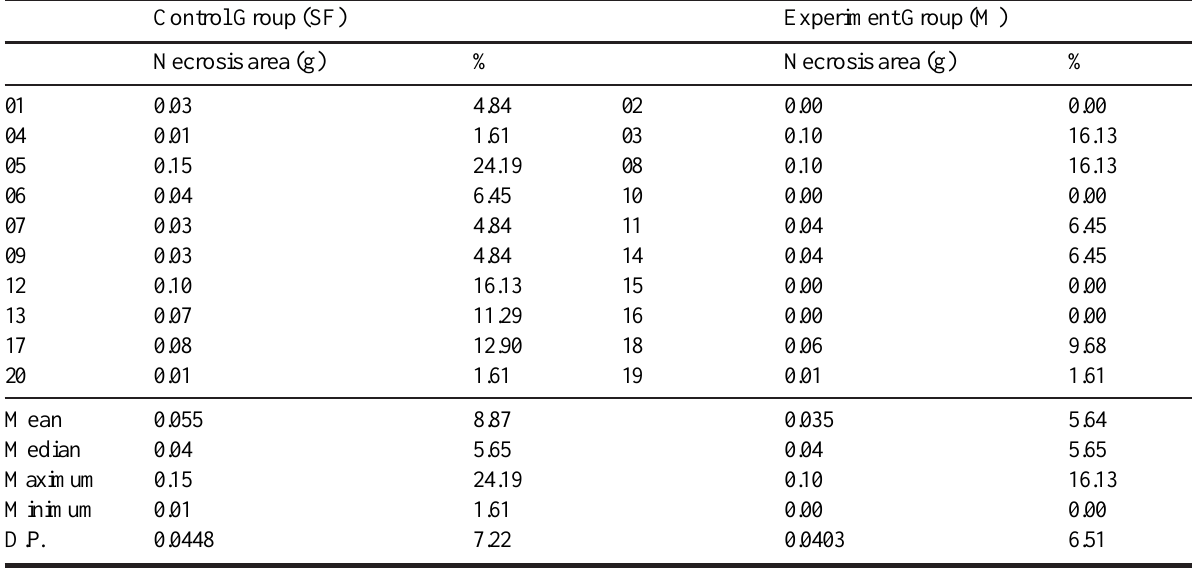
TABLE 3 - Necrosis evaluation through weight